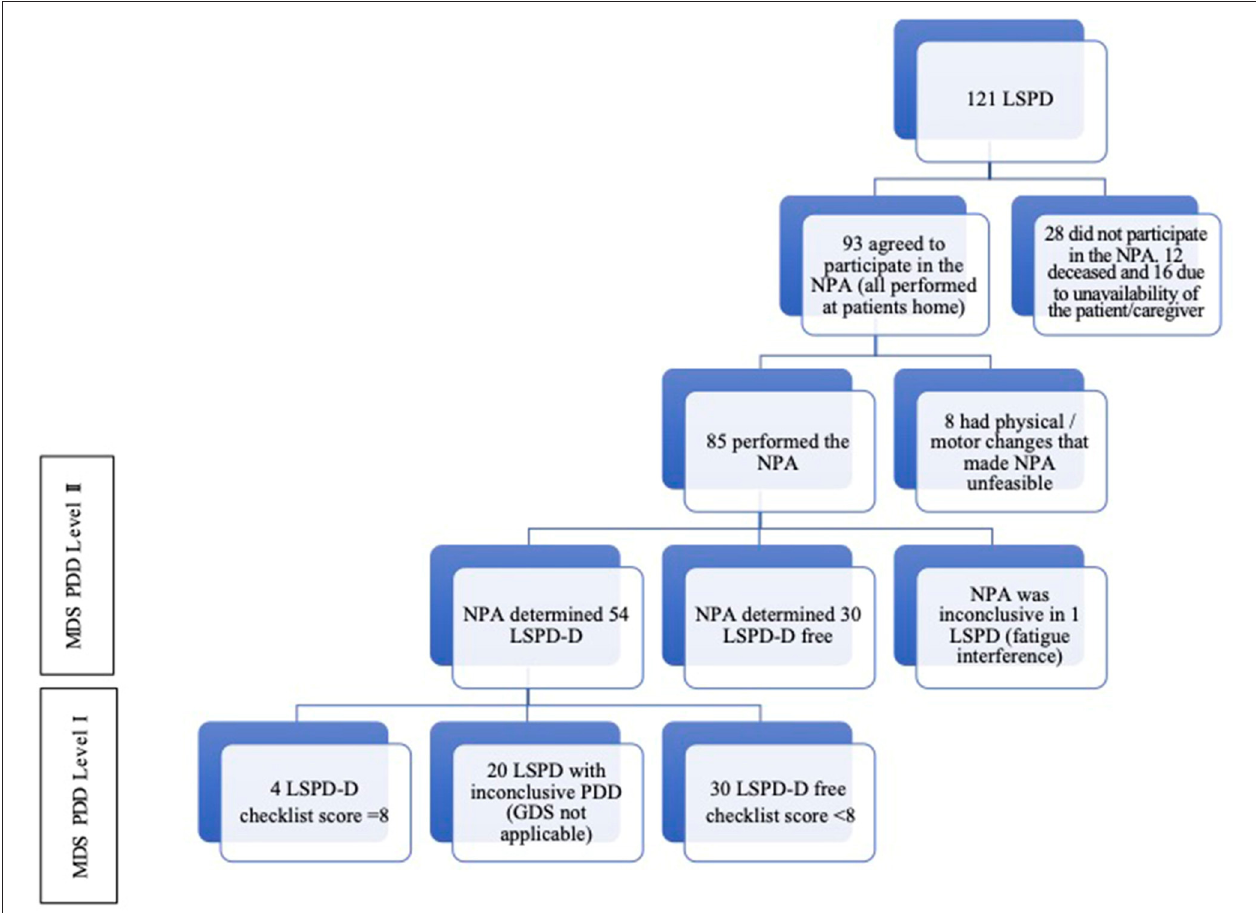
FIGURE 1 | Patients and assessments flowchart. MDS PDD, Parkinson’s Disease dementia criteria recommended by Movement Disorder Society Task Force (11); LSPD, Late-stage Parkinson’s Disease patients; LSPD-D, Late-stage Parkinson’s Disease dementia patients; NPA, Neuropsychological assessment; GDS, Geriatric Depression